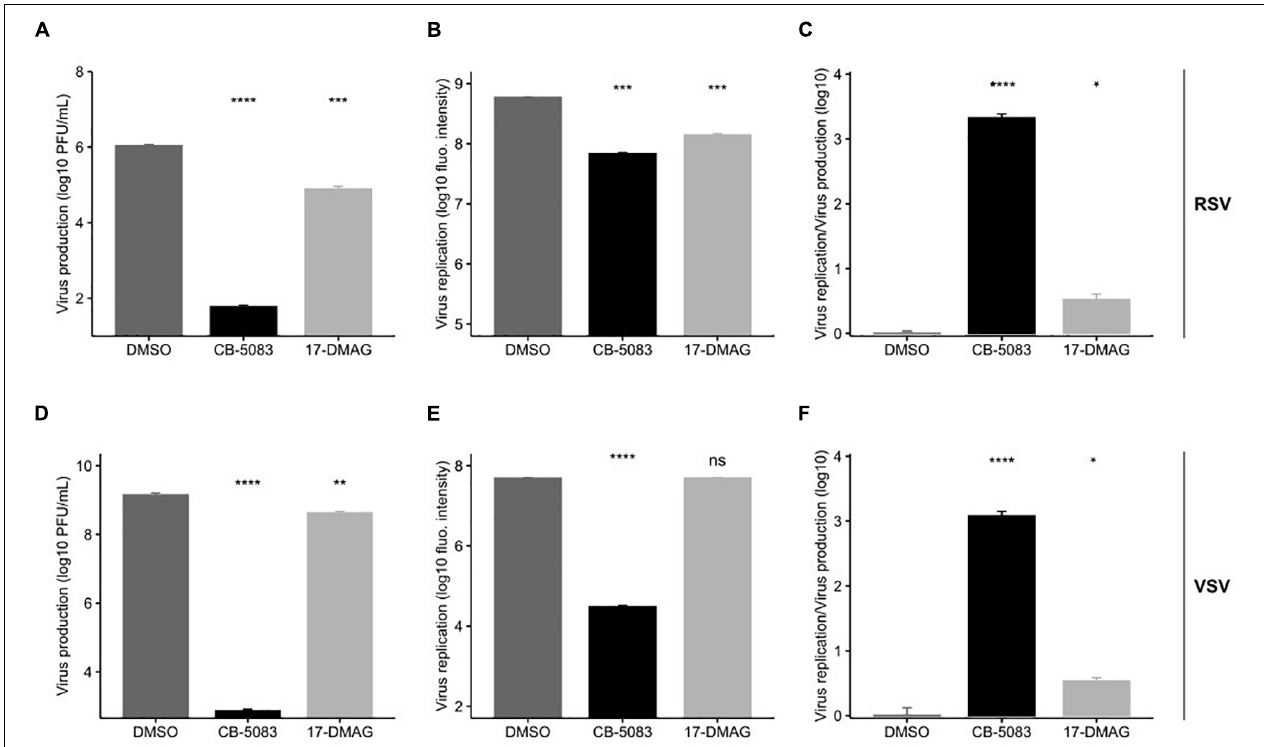
FIGURE 4 | VCP/p97 is involved in multiple steps of the RSV and VSV infection cycle. Cells were treated with the VCP/p97 inhibitor CB-5083 or the Hsp90 inhibitor 17-DMAG and infected with RSV (top row) or VSV (bottom row). Subsequently, virus production was measured by plaque assay (A,D) and intracellular replication was measured by the expression of a reporter protein (B,E) . The ratio of the antiviral effect observed for virus replication compared to virus production (C,F) . Plotted are the means and SEM for three replicates. ns p > 0.05; * p < 0.05; ** p < 0.01; *** p < 0.001; **** p < 0.0001 by t -test on log-transformed